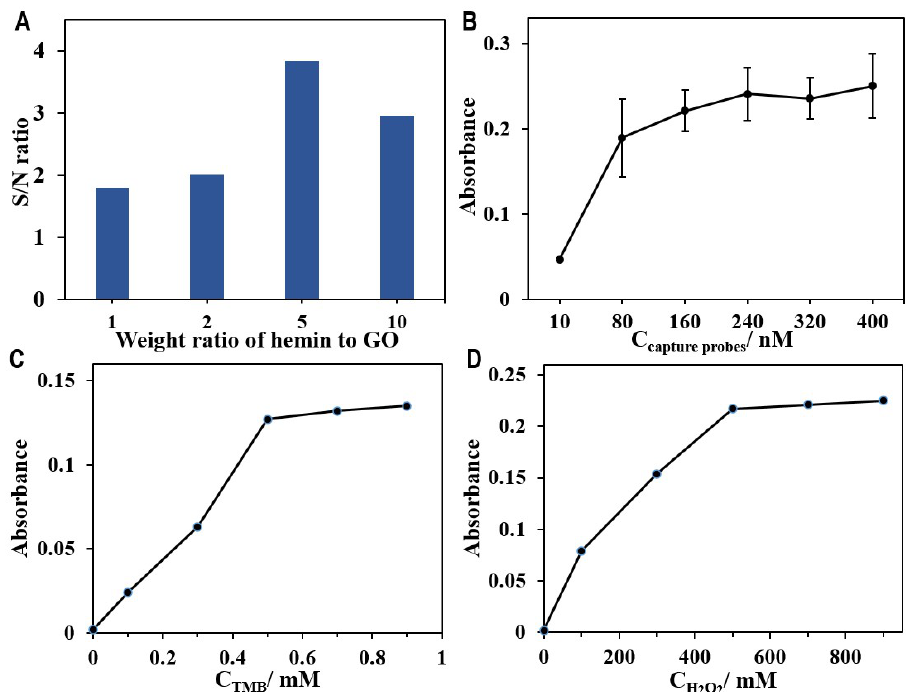
Figure 4. Optimization of the experimental conditions. ( A ) The signal-to-background ratios (S/N) of the aptasensor for detection of the same number of CEM cells with HGNs was prepared by varying the hemin-to-GO weight ratio from 1 to 10. ( B ) Optimization of the concentration of capture probes for preparing functionalized magnetic beads to determine CEM cells. Dependence of the concentration of TMB ( C , D ) H 2 O 2 on the peroxidase-like activity of HGNs with the hemin-to-GO weight ratio of 5. Besides the effect of the amount of hemin, the detection sensitivity of the aptasensor is also closely related to the concentration of capture probes used for magnetic